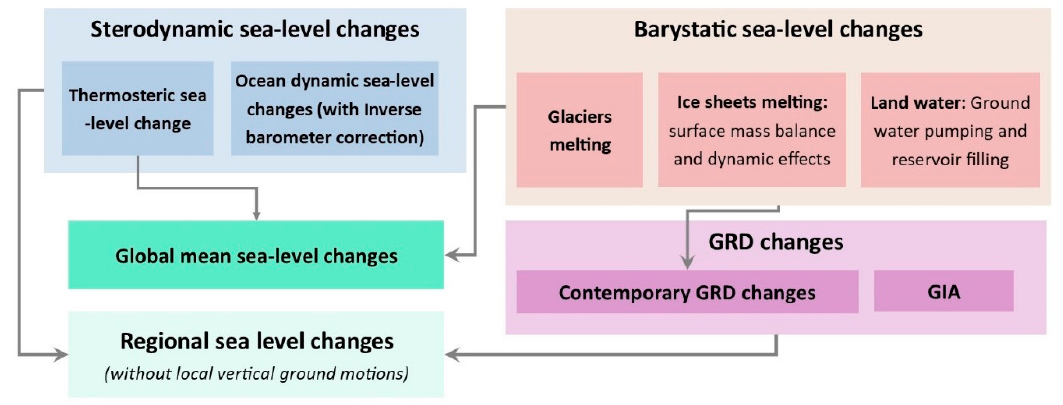
Figure 2. Method to compute global and regional sea-level changes (see Gregory et al., 2019 [42] for the terminology).